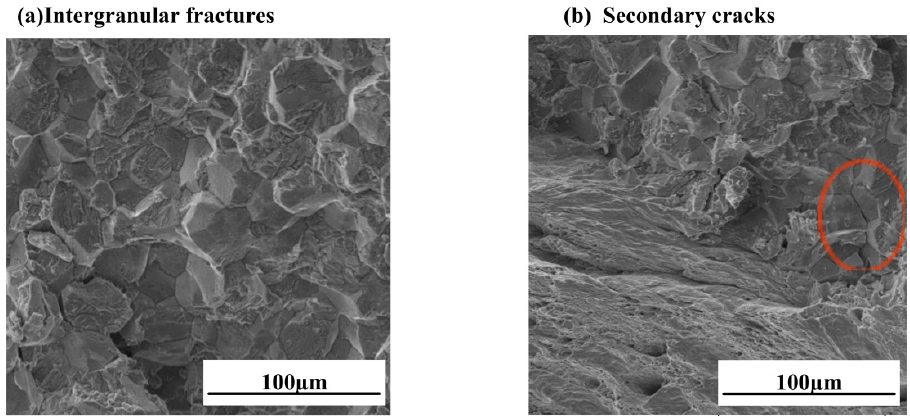
Figure 8. Intergranular corrosion characteristics of fracture surfaces. ( a ) Micromorphology of intergranular corrosion on the fracture surface and ( b ) Secondary crack morphology on fracture surface.